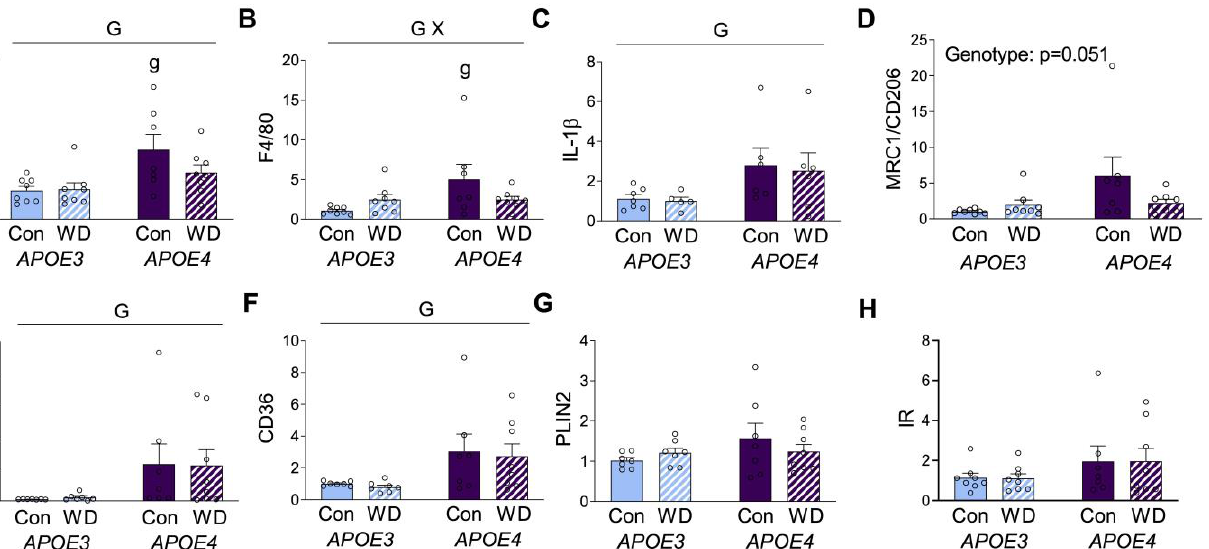
Figure 3. Gene expression levels in visceral adipose tissue. Results of mRNA quantification studies in APOE3 (blue) and APOE4 (purple) mice maintained on control (Con; solid bars) or Western (WD; hatched bars) diets. Gene targets included the macrophage markers ( A ) CD68 and ( B ) F4/80, the inflammation-related markers ( C ) IL-1 β and ( D ) CD206, and the metabolic macrophage markers ( E ) Abca1, ( F ) CD36, ( G ) PLIN2, and ( H ) insulin receptor (IR). Data show fold difference as individual values (open circles) and means (+SEM) relative to the Con APOE3 group from n = 7–8 mice per group. “G” indicates a significant main effect of APOE genotype, “X” indicates a significant interaction effect between APOE and diet, and “g” indicates a significant difference from APOE3 mice on the same diet. Significance is p < 0.05.